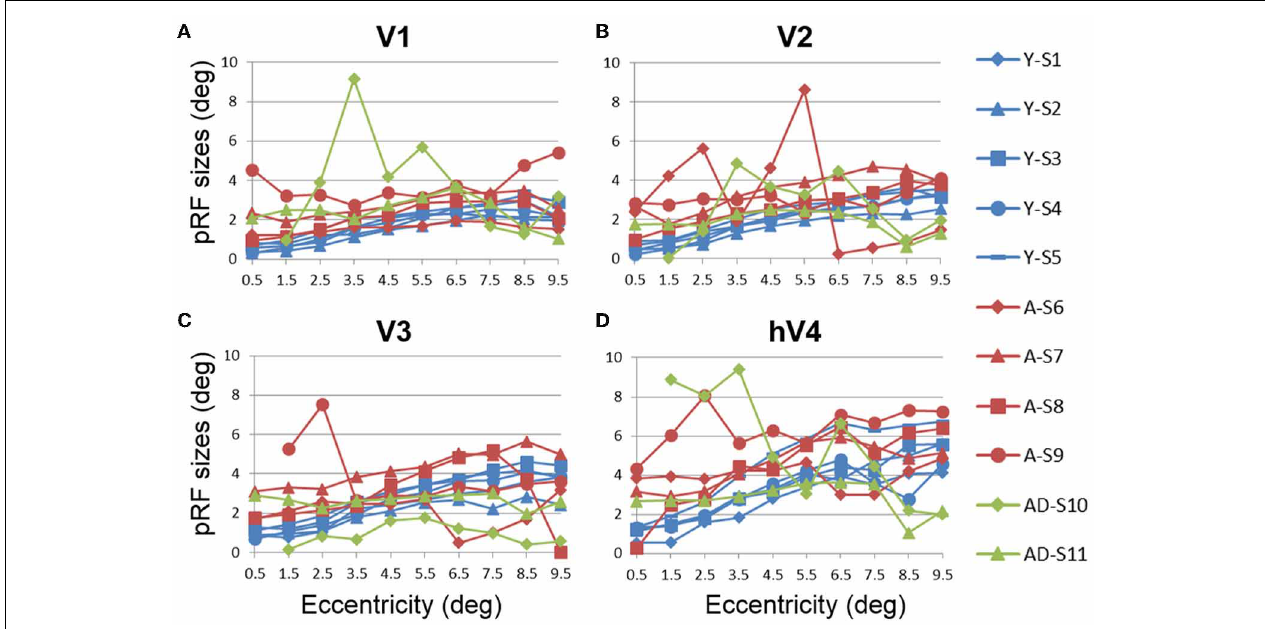
FIGURE 8 | Population receptive field size measurements for visual field maps in individual young, healthy aging, and mild Alzheimer’s disease subjects. (A) V1. (B) V2. (C) V3. (D) hV4. Blue lines represent data from healthy young subjects, red lines represent data from healthy aging subjects, and green lines represent data from mild AD subjects. Each line represents data measured in individual subjects and averaged